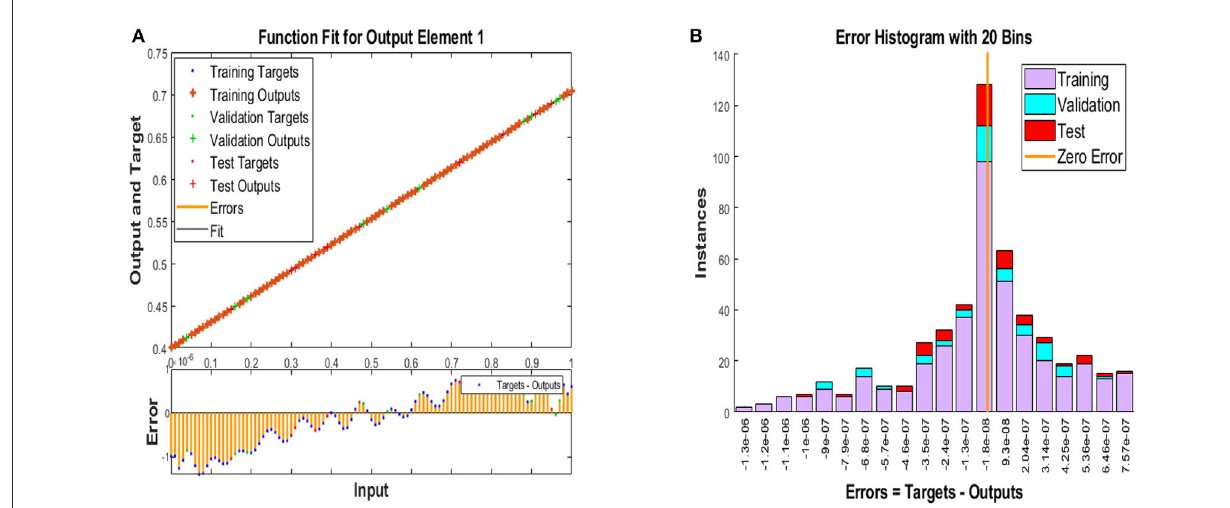
FIGURE9 Results and EHs performances for the HBV system. (A) Results: Case 3. (B) EHs: Case 3.